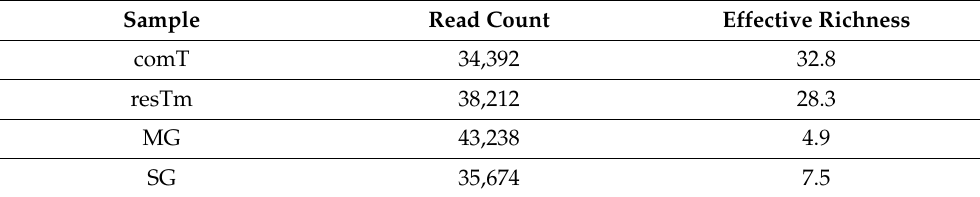
Table 1. Read count and α -diversity (effective richness) shown as average mean. Sample